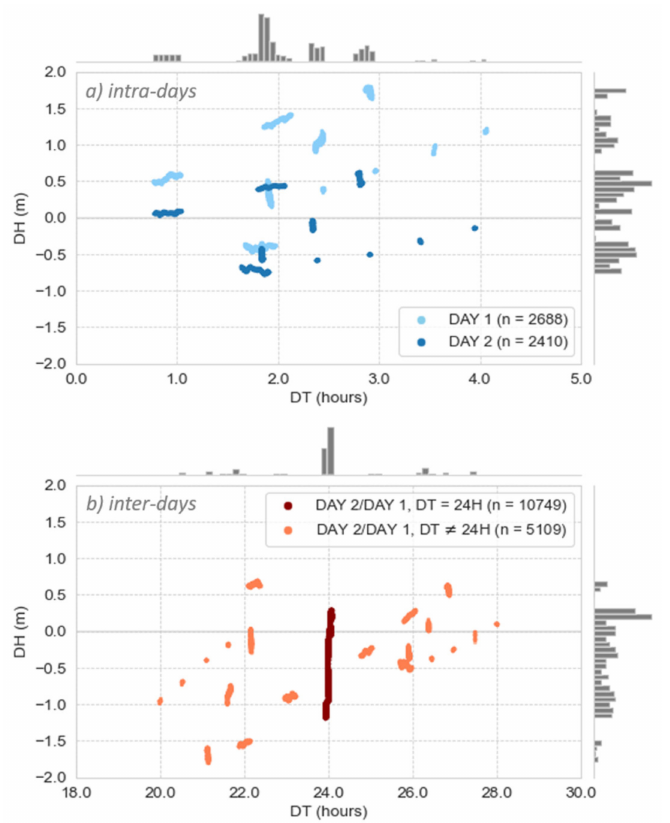
Figure 9. Representation of intra-day ( a ) and inter-day ( b ) crossover differences ( DH ) in function of the time interval dt . For each panel, top and right grey histograms, respectively, represent the temporal and height distributions of